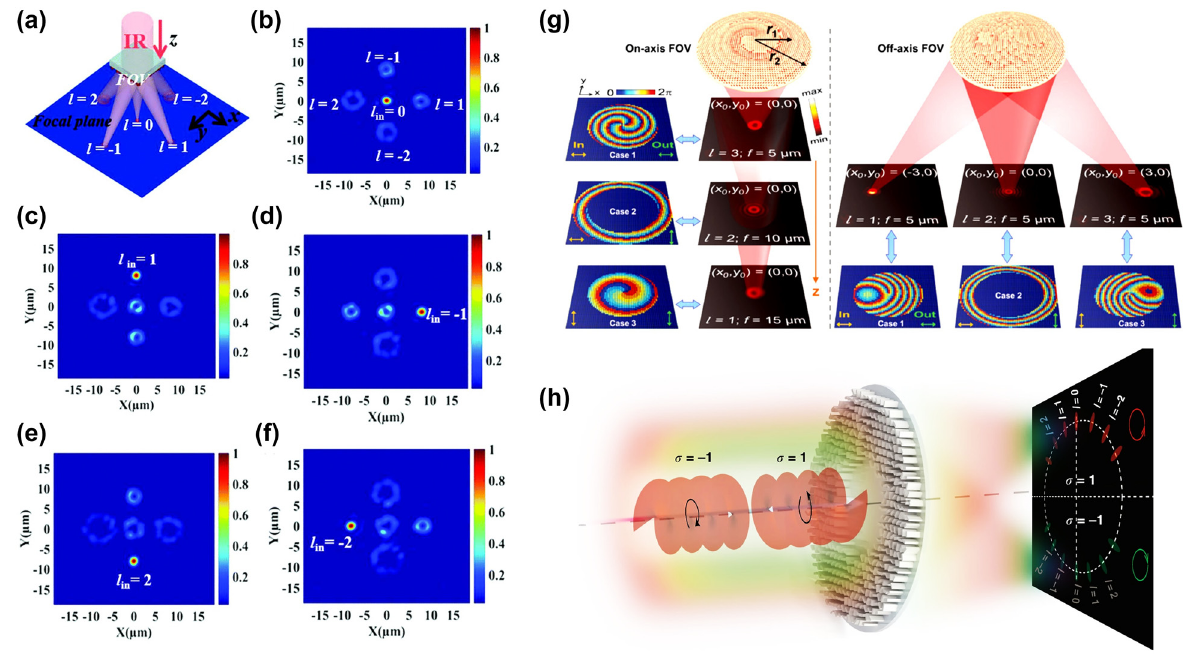
Figure 4: Metasurface for OV sorting. (a) Schematic of the multiple OV generator. The incident light is sorted into five OVs with different l . (b – f) The corresponding intensity distributions.Theincidentlightisimpingedwith(b) l =0,(c) l =1,(d) l = − 1,(e) l =2,(f) l = − 2[75].(g)Left:On-axisOVswith l =3,2,and1at f =5, 10, and 15 μ m. First column shows the calculated phase distributions. The 2nd column is far- fi eld intensity patterns. Right: Off-axis OVs with l =1,2,and3at f =5 μ m.1strowshowsthefar- fi eldintensitypatterns.The2ndrowisthecorrespondingcalculatedphasedistributions[76].(h) Schematic of dielectric metasurface that combines the PB phase and propagation phase for simultaneous OV and SAM sorting. OVs with various incident spins are translated into focusing spots on the screen with two separated halves